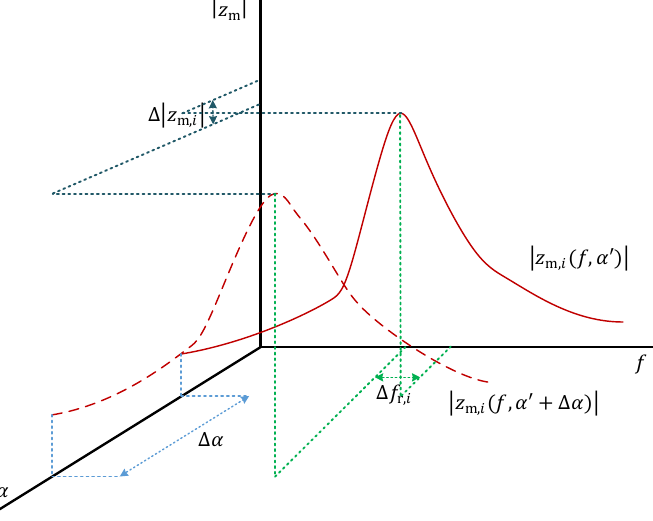
Figure 2. Network parameters change effect on a modal impedance characteristic.